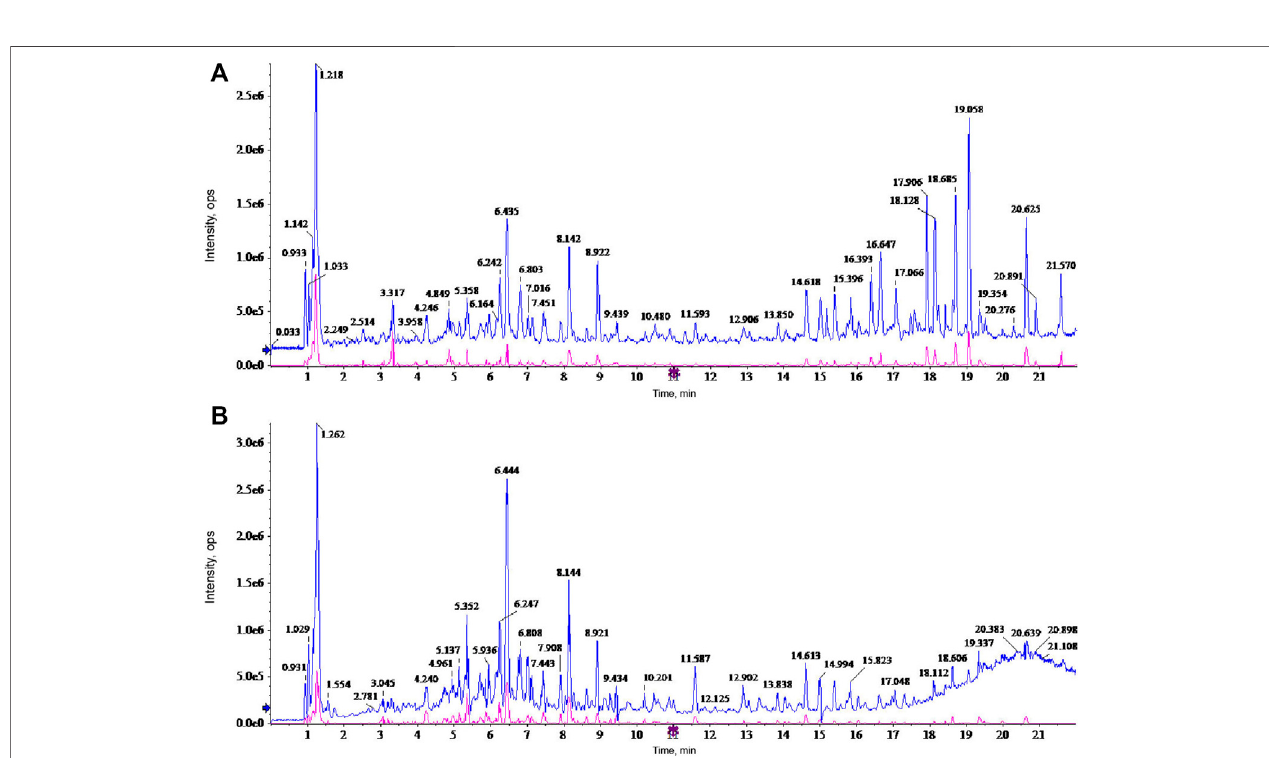
FIGURE 2 | Ion current chromatograms of AETW in positive (A) and negative (B) modes, respectively.